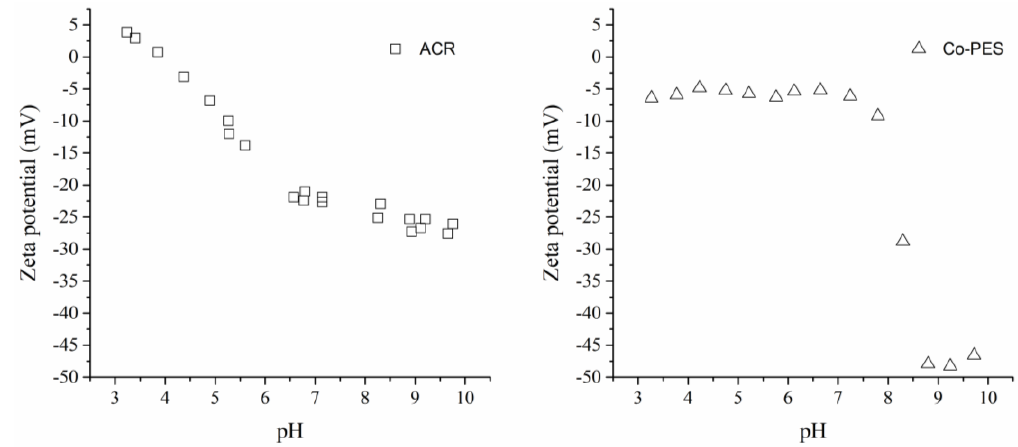
Figure 9. Zeta potential pH dependence of modified ACR dispersion ( squares ) and Co-PES dispersion ( triangles ).